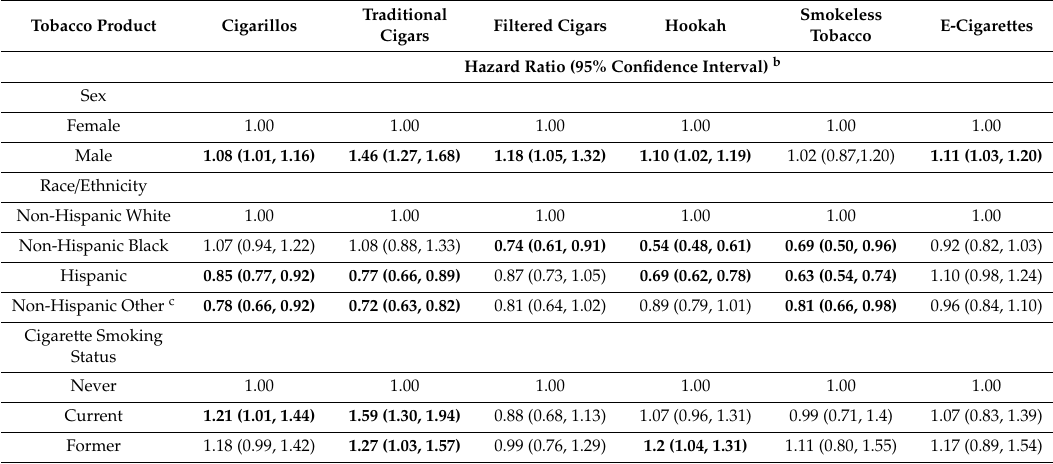
Table 3. Hazard ratio and 95% confidence interval reported for the recalled age of initiation of tobacco products by sex, race / ethnicity, and cigarette-smoking status among 26–34-year-old adults reported in 2013–2014 PATH a (wave